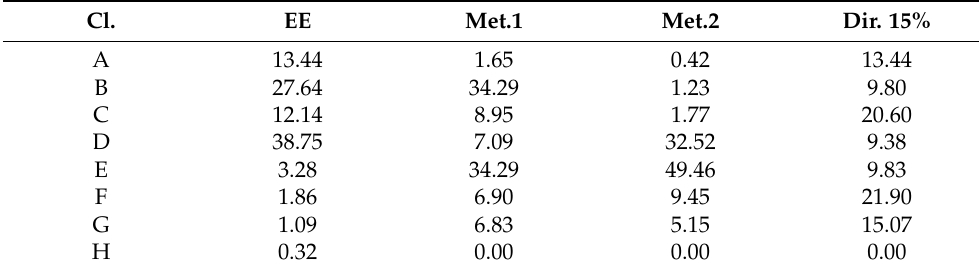
Table A3. EPC certificates % per energy class, dwellings D3 (A > 220 m 2 ). Cl.